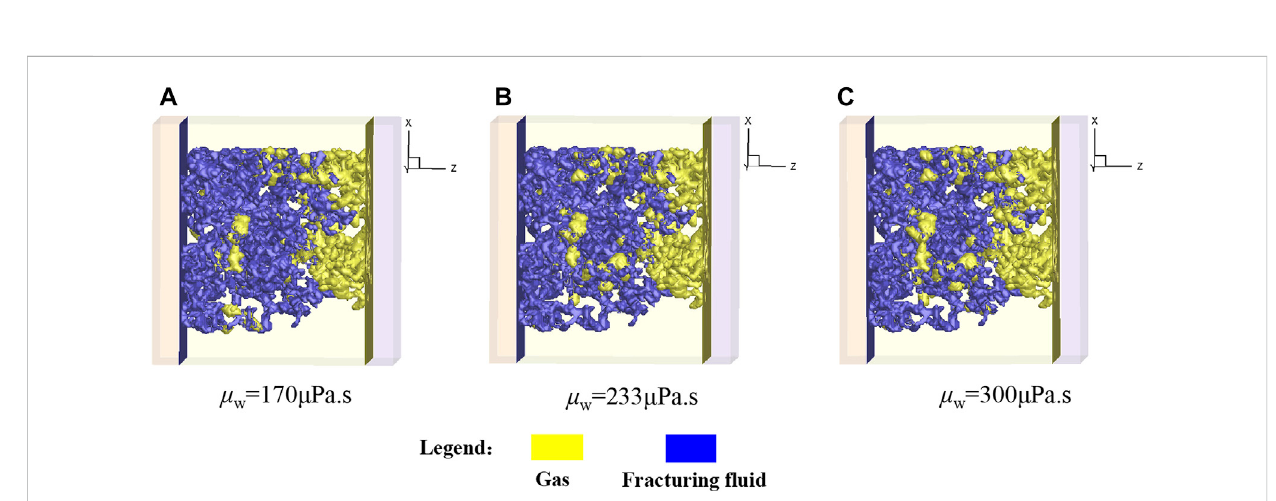
FIGURE 22 Gas-liquid distribution at theequilibrium state ( t (cid:2) 6 . 0 × 10 6 )inthe imbibition process underdifferentfracturing fl uid viscosities. (A) μ w = 170 μ Pa.s, (B) μ w = 233 μ Pa.s, (C) μ w = 300 μ Pa.s.